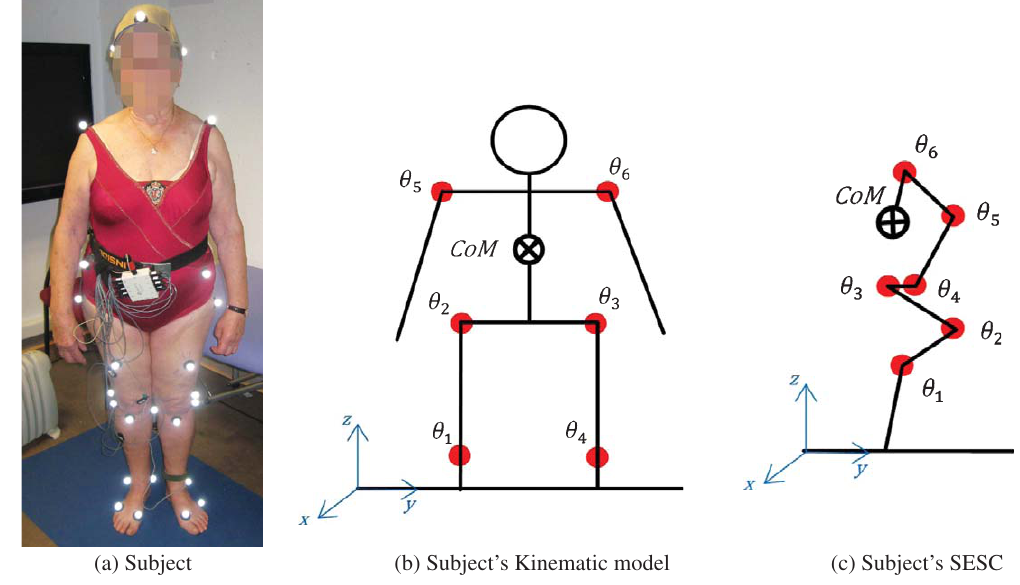
Fig. 1. These pictures illustrate the transformation process going from the subject (a) to her kinematic model (b) and finally her SESC (c) locating her CoM.